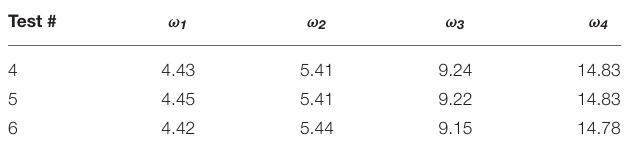
TABLE 2 | Frequencies (in Hz) identified in free vibration tests.